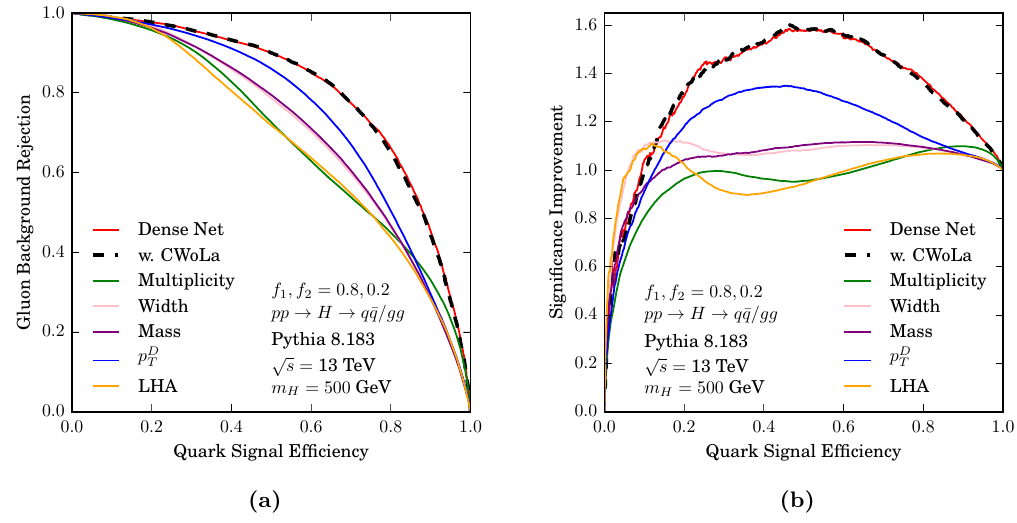
Figure 5 . Quark/gluon discrimination performance in terms of (a) ROC curves and (b) SI curves. Shown are results for the dense net trained on 150k pure samples, and then with CWoLa on f 1 = 80% versus f 2 = 20% mixed samples, as well as the input observables individually. The classi(cid:12)er trained on the mixed samples achieves similar performance to the classi(cid:12)er trained on the pure samples, with improvement in performance over the input